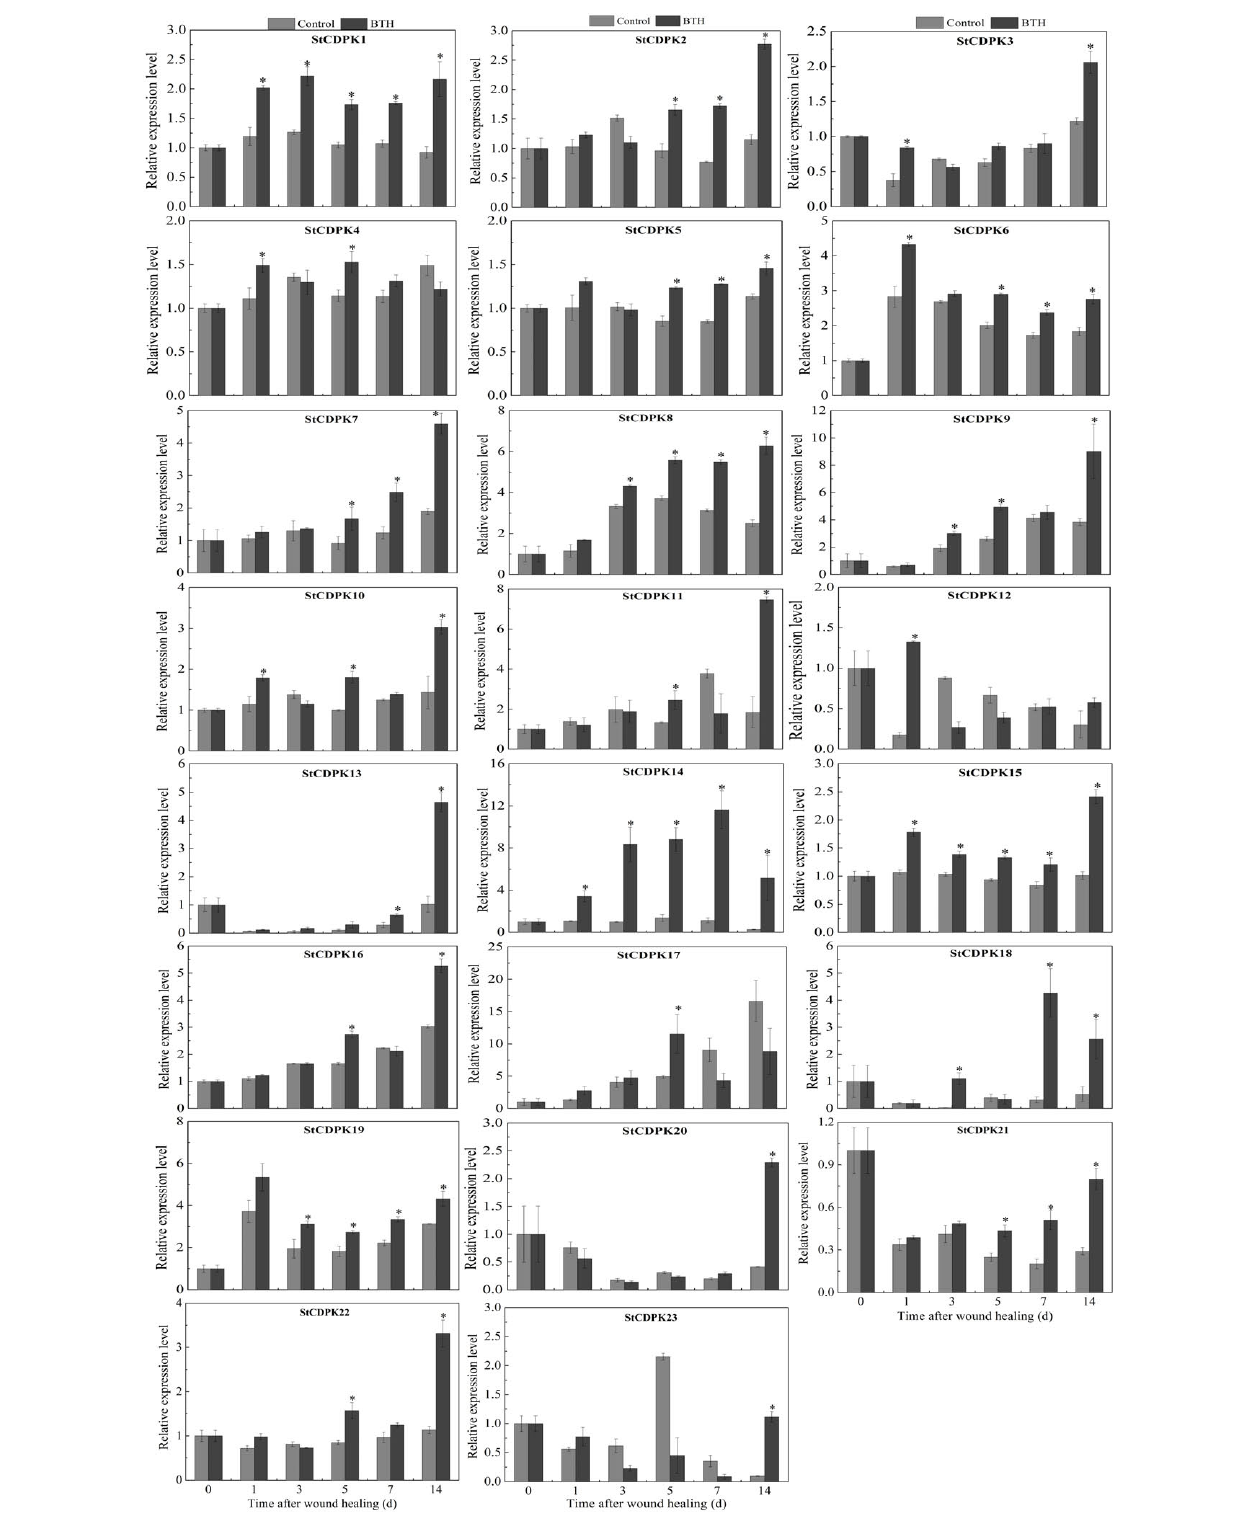
FIGURE 3 | Expression levels of Solanum tuberosum calcium-dependent protein kinases ( StCDPKs ) ( StCDPK1-StCDPK23 ) in healing tissues of tubers treated with BTH. The expression data at each time point is relative to that of 0 d (untreated tubers), which was set to 1. The mean ( ± SD) represents the value of three replicates. Asterisks indicate statistical significance ( P <